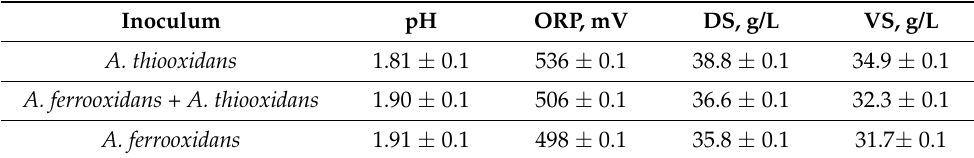
Table 3. Parameters of the inoculum used in the experiments.